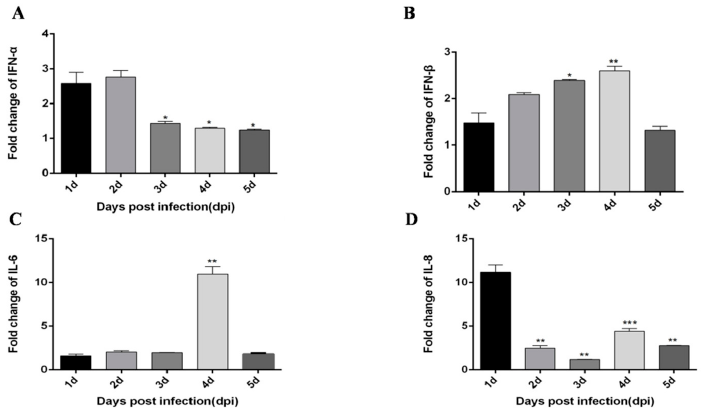
Figure 3. DTMUV-infected ducks effectively up-regulate IFN- α , IFN- β , IL-6, IL-8 expression in the liver. Each young SPF duck was challenged by intramuscular inoculation with DTMUV. ( A – D ) Liver tissues of mock- and DTMUV-infected ducklings were collected at the indicated time points for examination of IFN- α ( A ), IFN- β ( B ), IL-6 ( C ), IL-8 ( D ) mRNA expression using qRT-PCR. The average levels from three independent experiments are plotted. The error bars represent the SEs. * P < 0.05, ** P < 0.01.